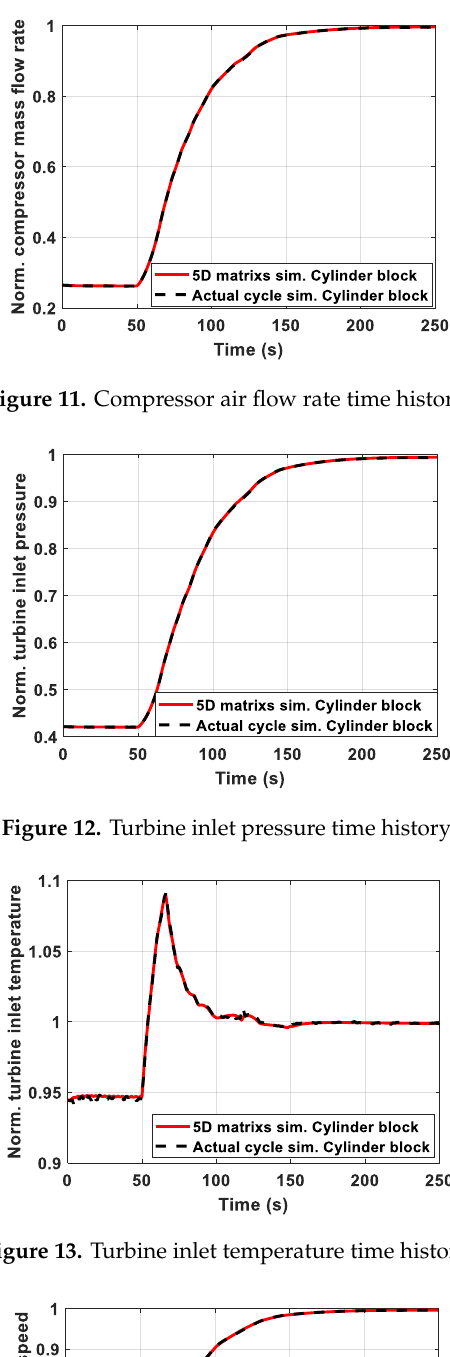
Figure 10. Compressor outlet pressure time history .